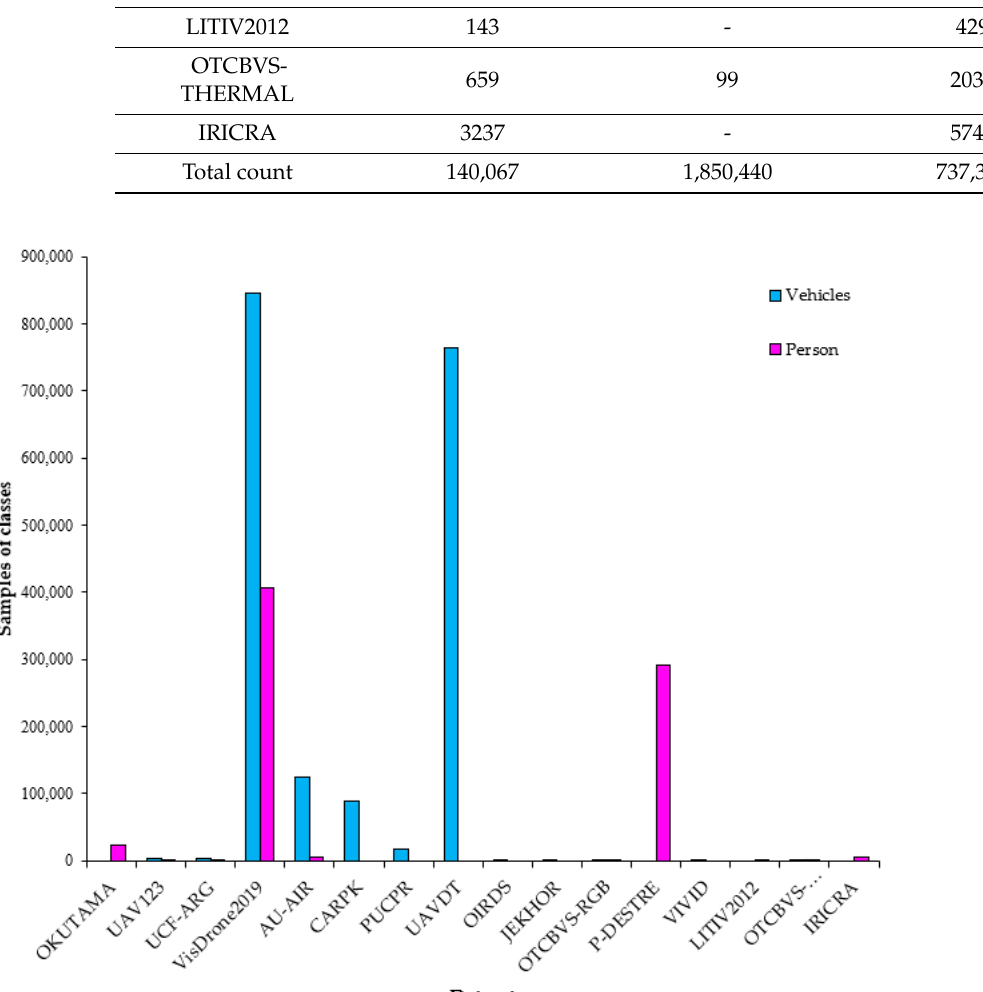
Figure 12. Distribution of the samples in each class per dataset used for the training and validation sets.